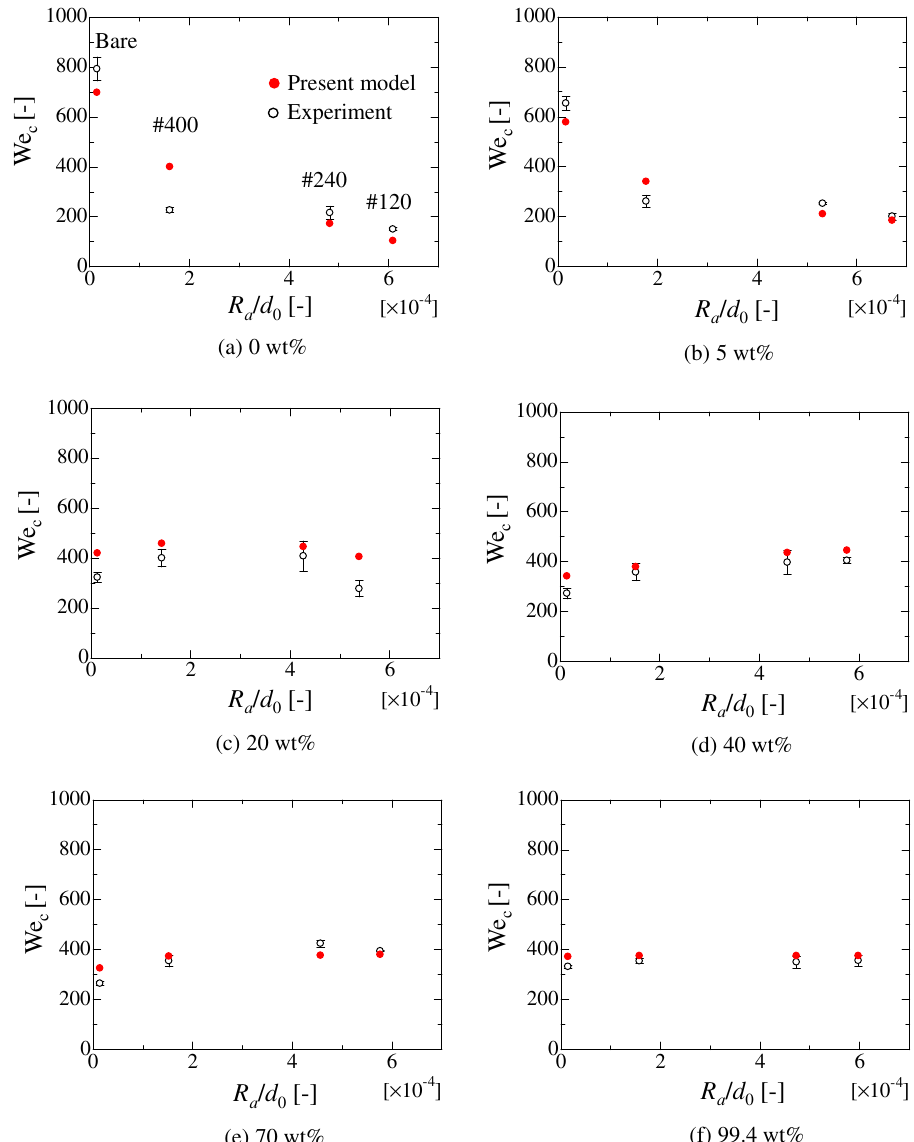
Figure 5. Comparison of the critical We calculated by Eqs. (A10) and (A18) with the experimental data for water–ethanol binary-mixture droplets on the solid substrates of PC. The horizontal axis reflects the arithmetical mean-roughness value R a normalised by the initial droplet diameter d 0 . The solid red circle represents the analytical result. The empty circle represents the experimental data. The error bar is twice of standard